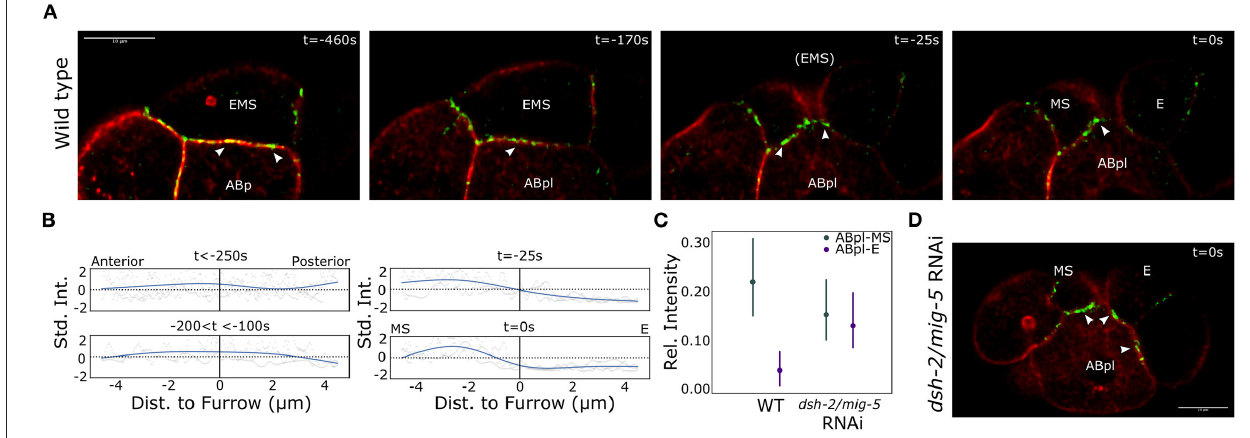
FIGURE 4 | Asymmetric E-cadherin distribution coincides with the asymmetric cortical dynamics in EMS. (A) Distribution of the E-cadherin HMR-1 across the interface between EMS and ABp/ABpl. Note that ABpl forms a lamellipodium that precedes the ABpl movement following EMS division. Life act marking F-actin in red, the E-cadherin HMR-1 in green. Arrow heads indicate HMR-1 foci as mentioned in the text. Scale bar indicates 10 µ m. (B) Quantification of the HMR-1 distribution over the ABpl/EMS interface. A natural spline is fit on the normalized data from three wildtype embryos. (C) The HMR-1 asymmetry is controlled by the Wnt signal. The RNAi effect on the distribution across the two cells is significant ( p < 0.005) in a mixed 2-way ANOVA test. Data from seven wildtype embryos and three dsh-2/mig-5 RNAi treated embryos. The signal is corrected for background, normalized for differences in signal range, and the model includes a random effect to capture embryo specific effects. Bars indicate 95% confidence interval. (D) Illustration of the HMR-1 signal in E and MS after completion of cytokinesis upon RNAi treatment for the disheveled genes dsh-2/mig-5 . Colors are as for (A)